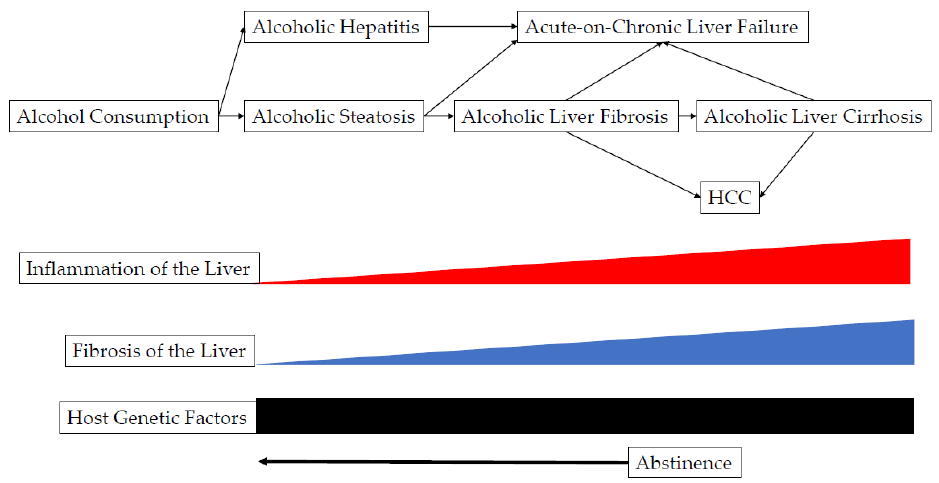
Figure 2. Molecular mechanisms: the connections between alcohol consumption and hepatocellular carcinoma.